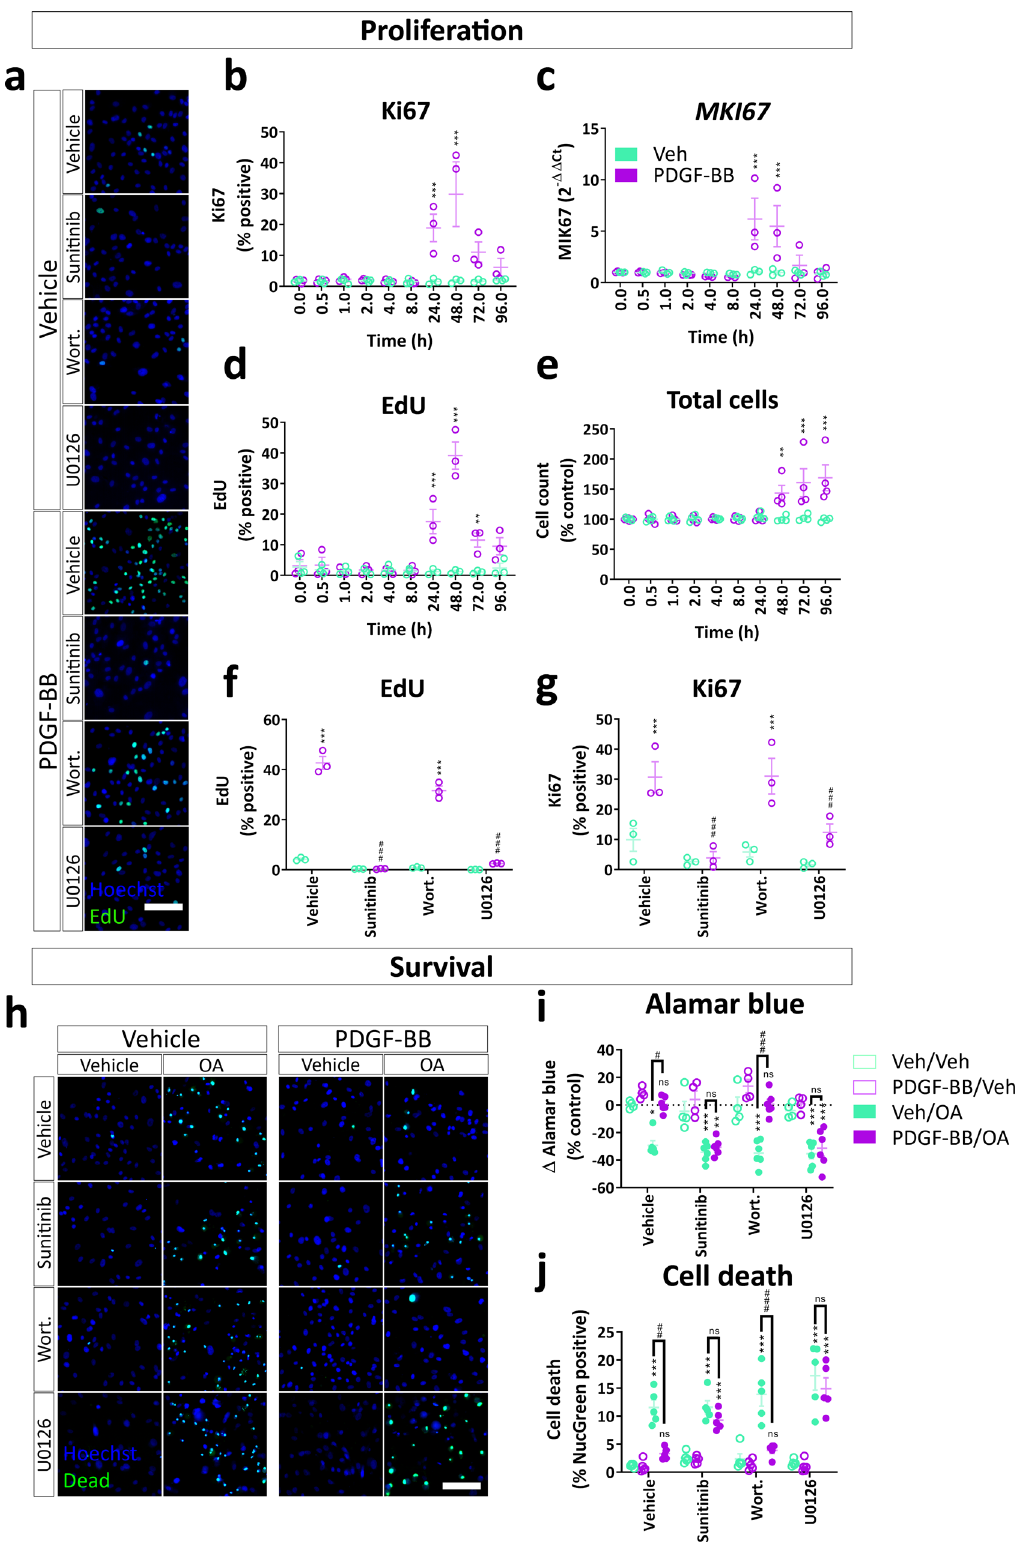
important to determine the functional consequences of the exposure to PDGF-BB are also relevant in vivo. This report also provides evidence for impaired PDGF-BB:PDGFR β signalling in AD, and identi fi es potential pathways that may be lost in pericytes in the AD brain. This raises the possibility that PDGFR β agonists may also be